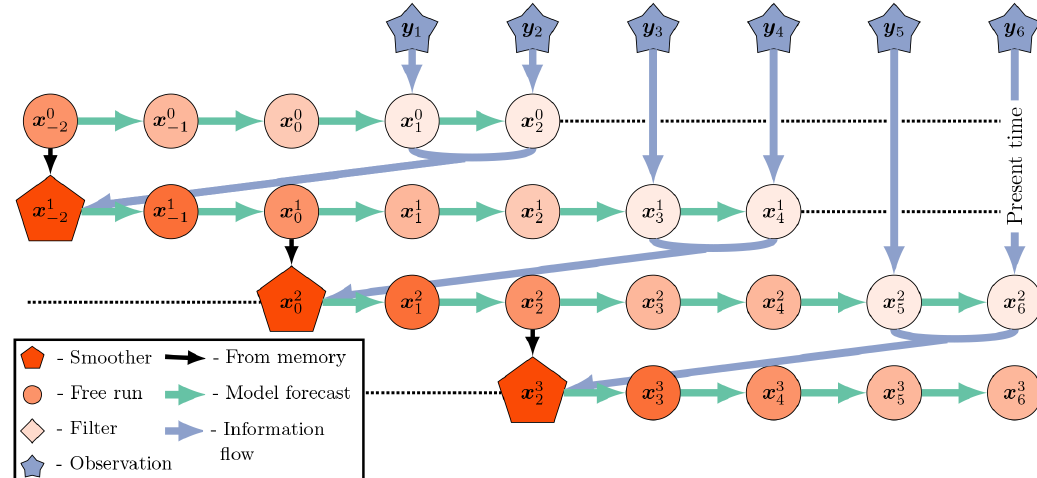
Figure 4. The (Lin-)IEnKS with a lag = 4 and a shift = 2. An initial condition from the last smoothing cycle initializes a forecast simulation over the current DAW of the L = 4 states. Unlike the SIEnKS, all new observations entering the DAW are assimilated globally at once via the 4D cost function. The innovations of the free forecast over all of the observation times are used to produce a retrospective reanalysis of the initial ensemble. Finally, the reanalyzed initial condition is evolved, via the model, S analysis times forward to begin the next cycle. Unlike the SIEnKS and the EnKS, the filter analysis of the (Lin-)IEnKS is performed by dynamically interpolating the smoothing estimate over new observation times with a free forecast in the subsequent cycle. The Lin-IEnKS is differentiated from the IEnKS by using only a single free ensemble forecast to produce the 4D optimization of the initial ensemble in each